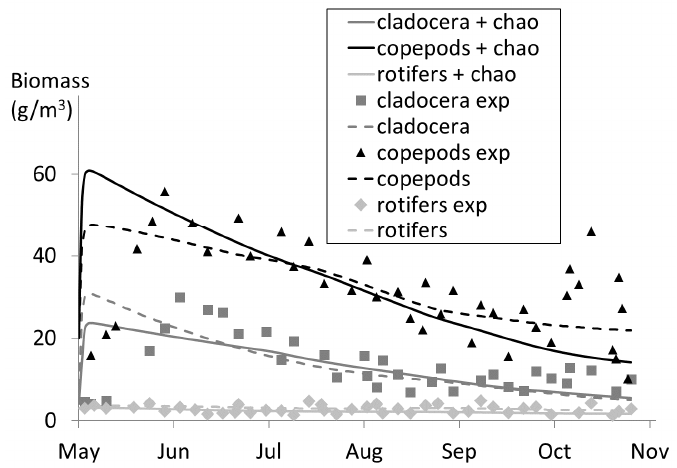
Figure 6. Calibration results for zooplankton. MSRE values (g/m 3 ): copepods: 77; copepods/ Chaoborus : rotifers: 0.99; rotifers / Chaoborus : 0.66; Cladocera: 110; Cladocera / Chaoborus : 106 (legend: zooplankton 25; rotifers: 0.99; rotifers/ Chaoborus : 0.66; Cladocera: 110; Cladocera/ Chaoborus : 106 (legend: zooplankton name + chao = simulation results from the extended model; zooplankton name =